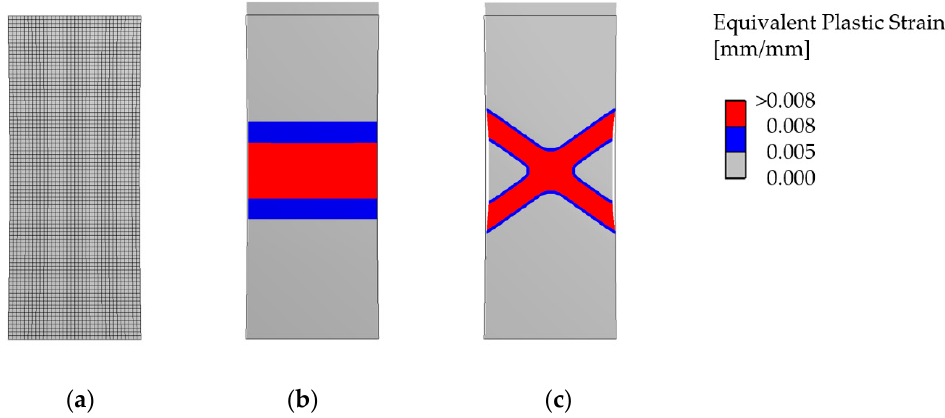
Figure 5. Failure mechanisms (equivalent plastic strain) from a finite element analysis (FEA) for the tensile specimen: ( a ) Mesh; ( b ) yield surface according to the T resca criterion was used; ( c ) yield surface according to the M ises criterion was used.